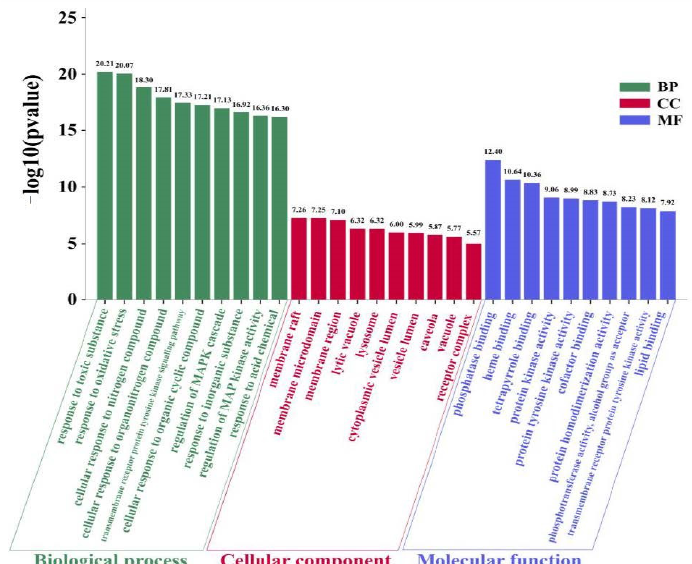
Figure 4. Gene Ontology (GO) enrichment analysis for NT-CTs including three categories: Biological progress (BP), cellular component (CC), and molecular function (MF). The top 10 terms ranking by - log10(pvalue) are shown.